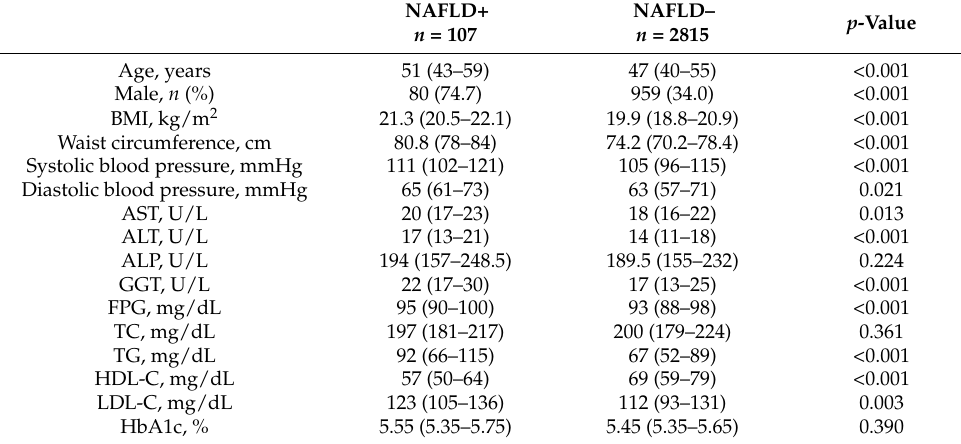
Table 4. Comparison of the characteristics between subjects with NAFLD and without NAFLD with a negative ZJU index and FLI.